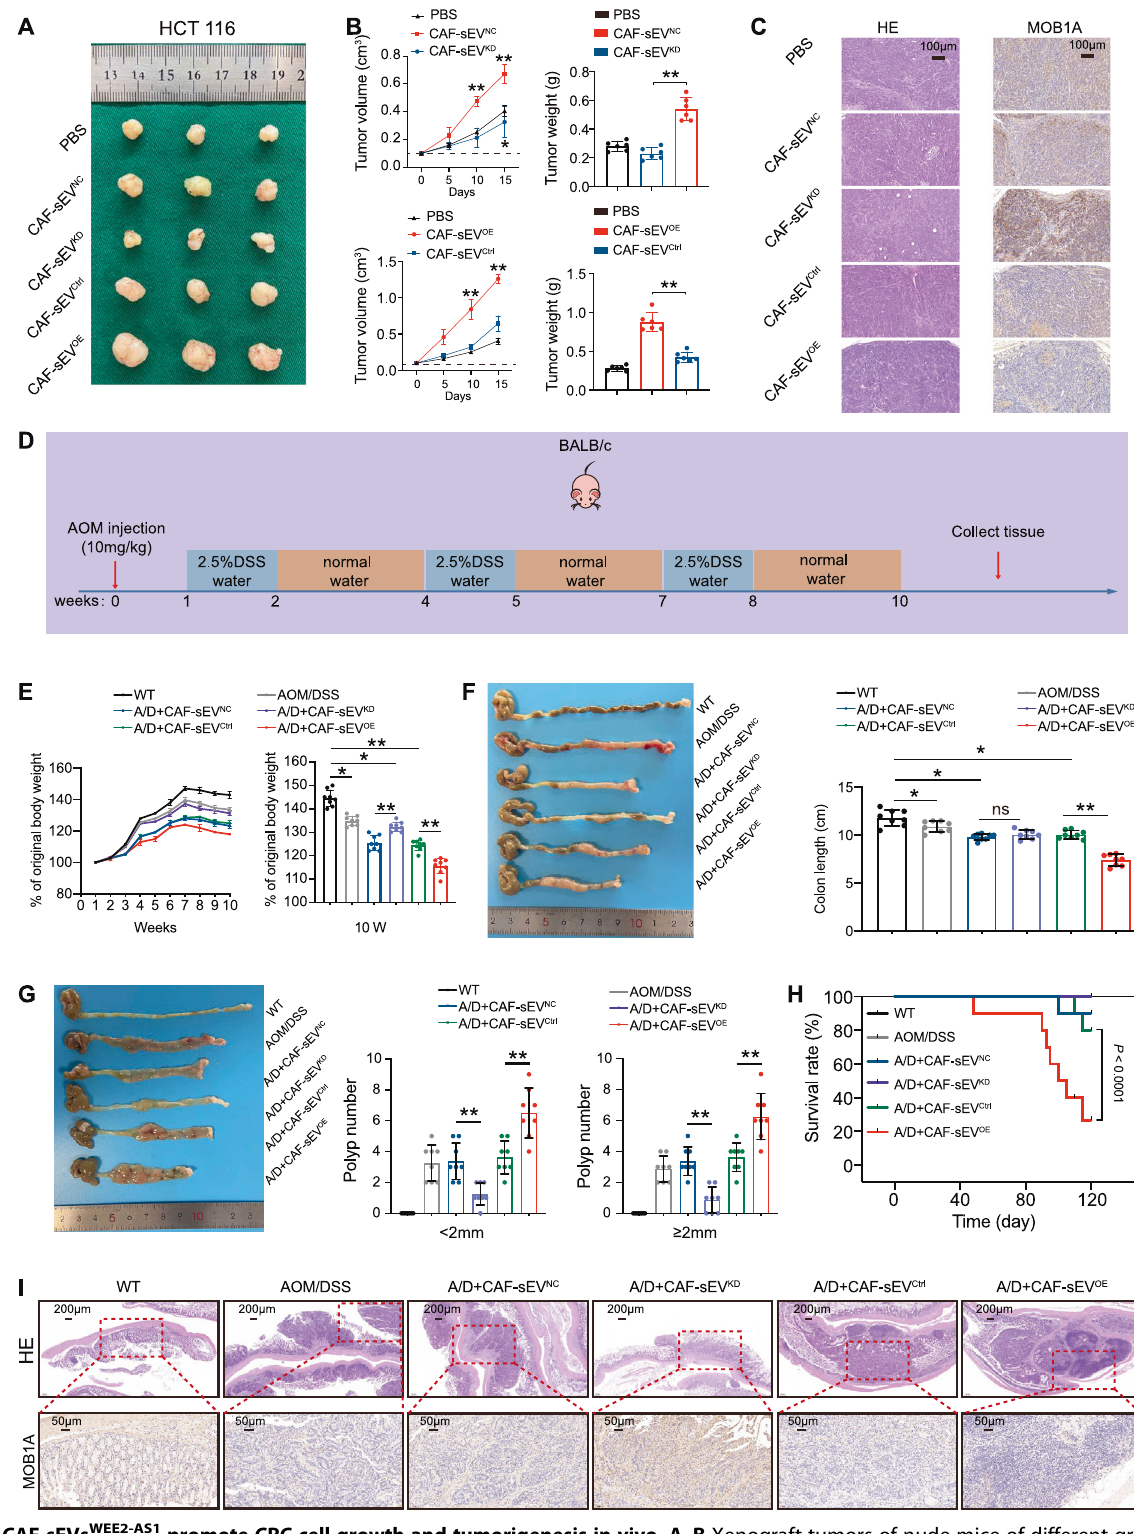
Fig. 7 CAF-sEVs WEE2-AS1 promote CRC cell growth and tumorigenesis in vivo. A , B Xenograft tumors of nude mice of different groups with sEVs treatment ( n = 6 per group). Tumor weight and body weight were measured at the endpoint. C HE and IHC of MOB1A in tumors of different groups (scale bar: 100 μ m). D Schematic diagram of AOM/DSS -induced CRC in BALB/c mice. E The relative body weight changes of BALB/c mice are shown with time. F Representative images of colons (left) and colon lengths of the WT, AOM/DSS, A/D + CAF-sEVs NC , A/ D + CAF-sEVs KD , A/D + CAF-sEVs Ctrl , and A/D + CAF-sEVs OE mice (right), ( n = 8 per group). G Representative images of colons (left) and the number of colonic tumors at least 2 mm or smaller than 2 mm per mouse (right). H Survival curves for the indicated mice ( n = 10 per group). Statistical signi fi cance was determined by the Kaplan – Meier log-rank test. I HE and IHC of MOB1A in tumors of different groups (scale bar: 200 μ m). * P < 0.05, ** P < 0.01, *** P < 0.001, ns. not signi fi cant. Cell Death and Disease (2022)